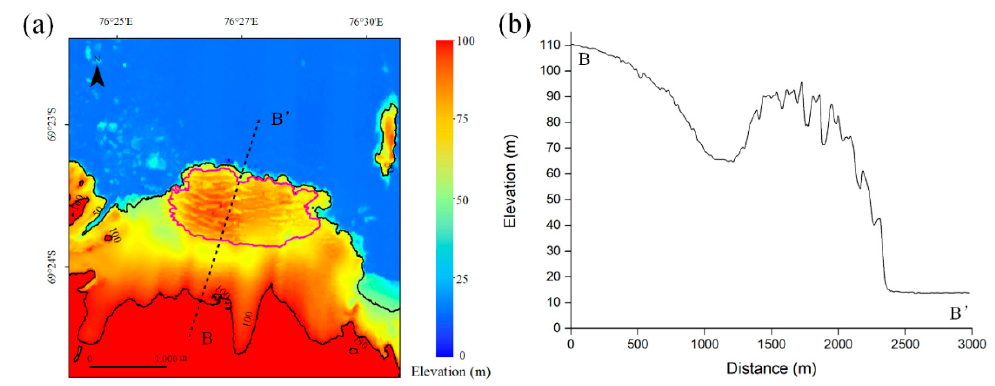
Figure 6. Overview of the ice rumple at the terminus of Dalk Glacier. ( a ) DEM of the glacier terminus at Dalk Glacier. ( b ) Elevation along the longitudinal profile (BB’). The pink line shows the possible range of the ice rumple.